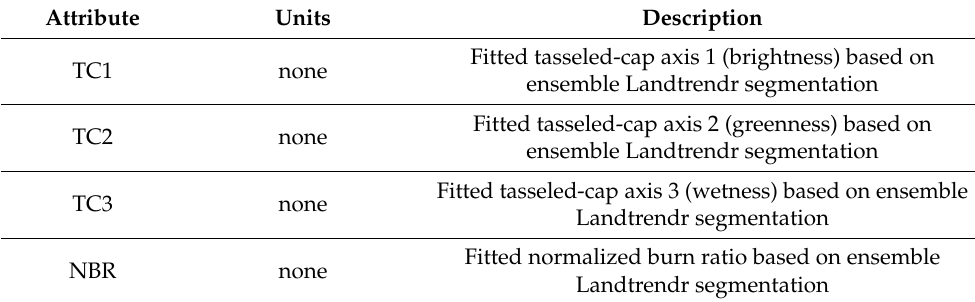
Table 4. Landsat spectral derivatives using ensemble LandTrendr.